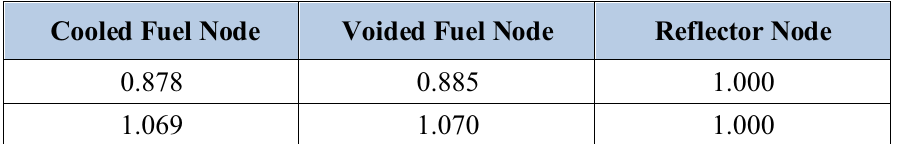
Table V. Assembly Discontinuity Factors